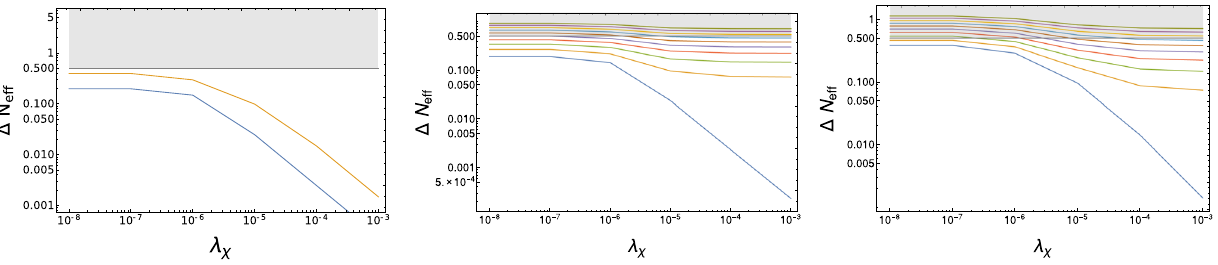
Fig. 4 (cid:12) N eff (taking contribution from both pseudoscalar and sterile neutrino) in Y-axis versus λ χ in X-axis, the left-most plot corresponds to the case when the inflaton decays only into the Higgs. The parame- ter values, namely, are m φ = 10 − 6 M Pl , λ φ = 10 − 14 , λ H = 10 − 7 , σ φ = 10 − 10 M , λ φχ = λ φ = 10 − 7 , 10 − 6 from bottom to top H Pl H